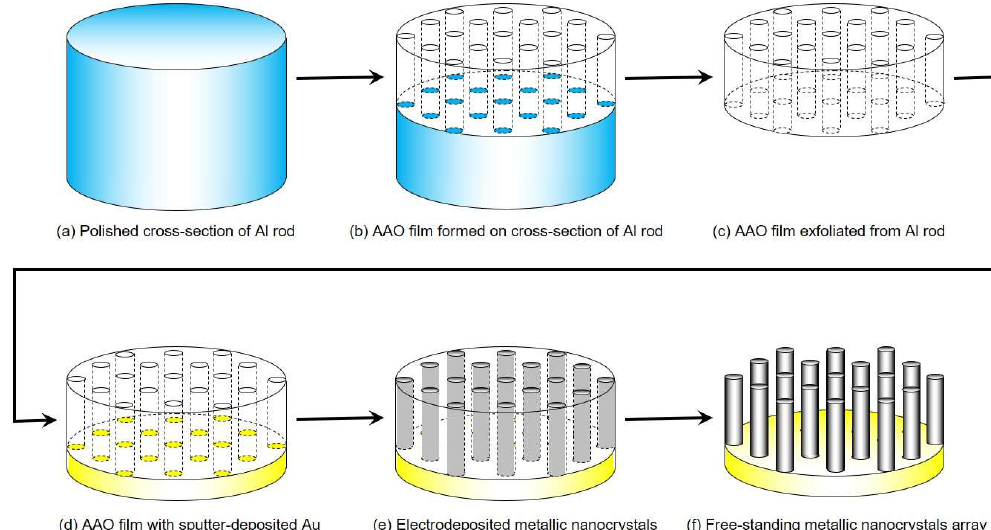
Figure 1. Fabrication process of free-standing metallic nanocrystals array. ( a ) polished cross-section of Al rod, ( b ) anodized aluminum oxide (AAO) film formed on the cross-section of Al rod, ( c ) AAO film exfoliated from Al rod, ( d ) AAO film with sputter-deposited Au, ( e ) electrodeposited metallic nanocrystals, and ( f ) free-standing metallic nanocrystals